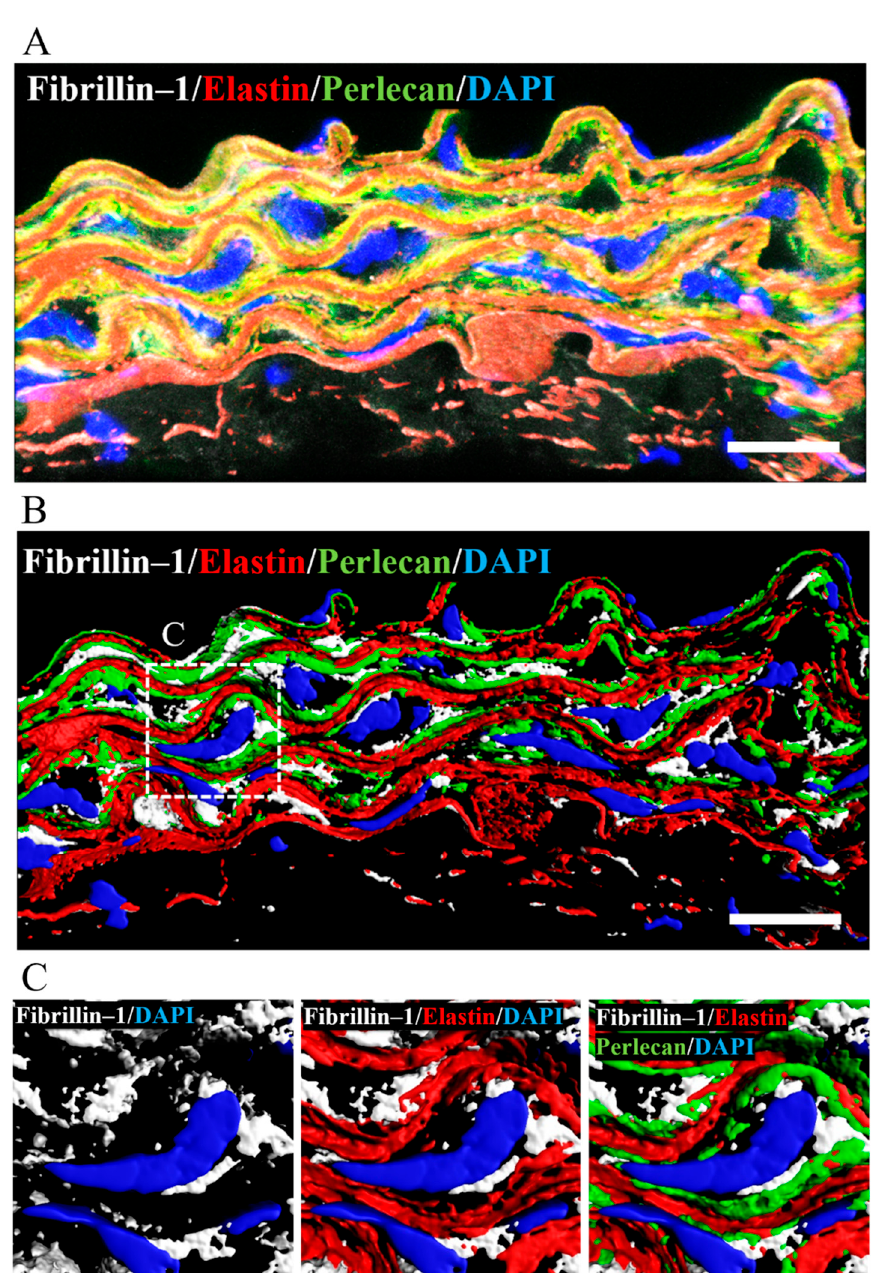
Figure 7. Perlecan co-localized with fibrillin-1 and elastin in WT-Tg mice aorta. ( A ) Immunostaining was performed with anti-perlecan (green), -elastin (red), and -fibrillin-1 (white) antibodies. ( B ) The image is displayed in 3D using the IMARIS software after surface reconstruction of each labeling. Perlecan was localized along the elastic lamina. ( C ) Close up of the insert in B. Perlecan was localized at the intersection between elastin and fibrillin-1. (Scale bar = 20µm). The images for Hspg2 − / − -Tg mice aorta are shown in supplementary Figure S2.